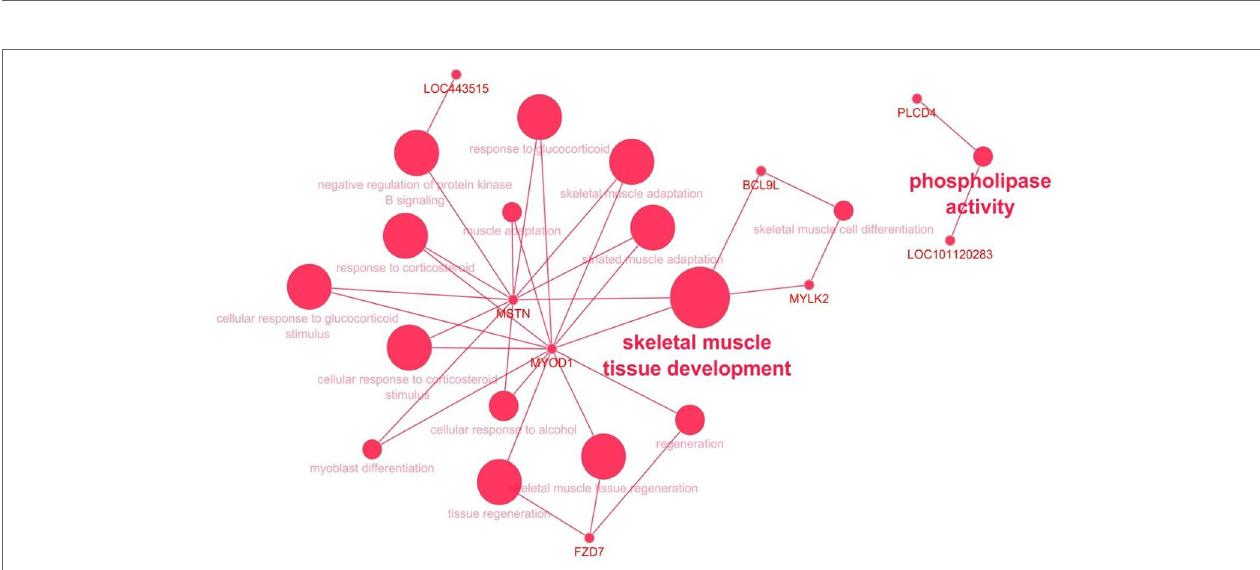
FiGURE 4 | The biological role of up- (green) and downregulated (red) genes in the LT muscle of ALF animals visualized with ClueGO. The size of the nodes reflects the statistical significance of the term.